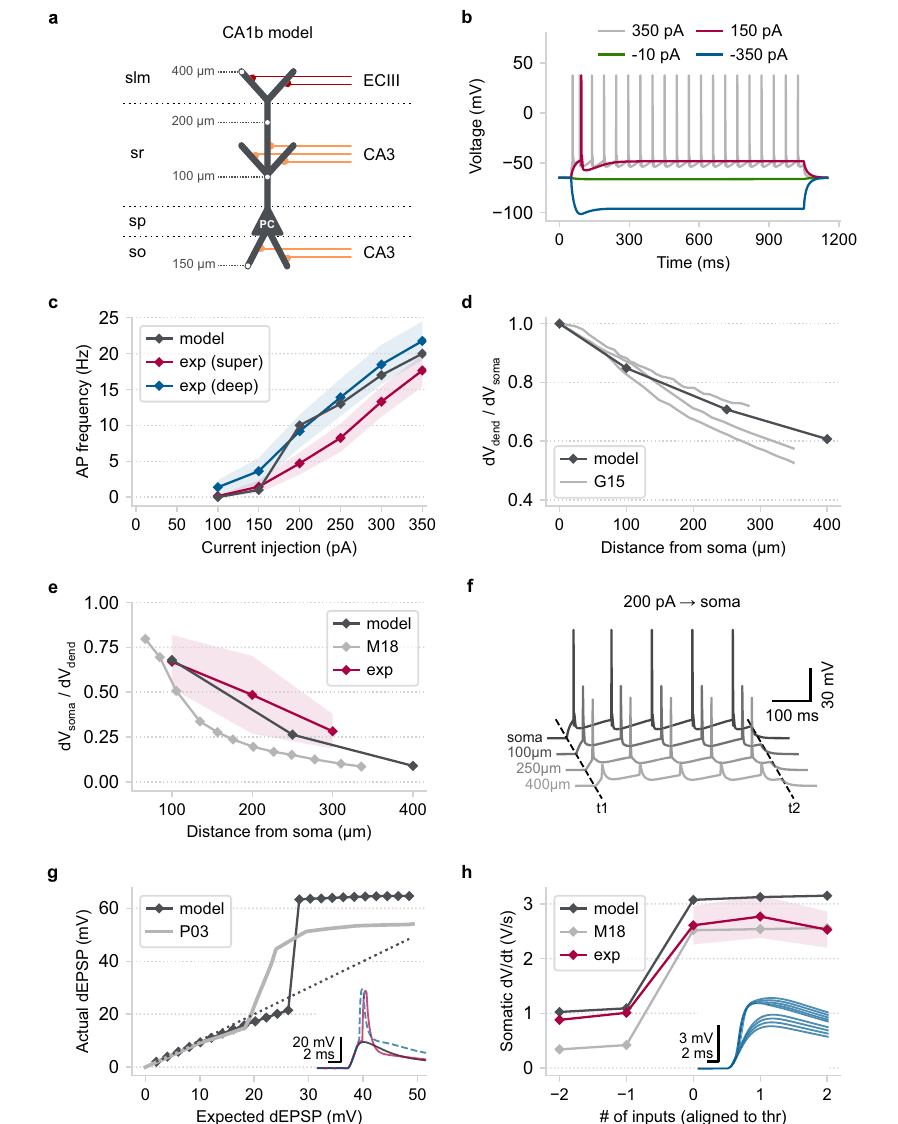
Fig. 4 | CA1 pyramidal model validation. a Schematic illustration of the reduced CA1 PC model consisting of a somatic and eight dendritic segments (2× basal, 1× proximal trunk, 1× distal trunk, 2× radial oblique, 2× distal tuft). Grey numbers: distanceoftheindicatedpointsfromthesoma.Redaxons:EClayerIIIinput,orange axons: CA3 input. Horizontal dotted lines: borders of the four CA1 layers (slm: stratum lacunosum-moleculare, sr: stratum radiatum, sp: stratum pyramidale, so: stratum oriens). b Somatic voltage responses to various (1000ms long) current injections used formodelvalidation. c F – I curves comparing themodelwith actual super fi cial and deep PCs located in the CA1b area 54 . Shaded area: SEM. d Steady- state, distance-dependent voltage attenuation of a long current pulse injected at the soma. G15: data for three detailed biophysical models adapted from 55 . e The attenuation of postsynaptic currents propagating along the apical dendrite as a function of distance from the soma. M18: biophysical modeling data adapted from 67 , Exp: experimental data adapted from 102 . Shaded area: two standard